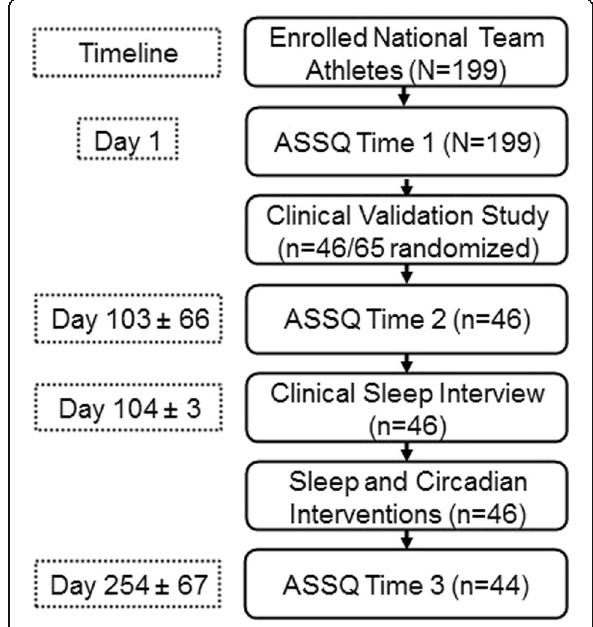
Fig. 1 Study timeline and protocol. Cumulative days (mean± SD) elapsed in the study (left dot boxes) between protocol procedures (right solid